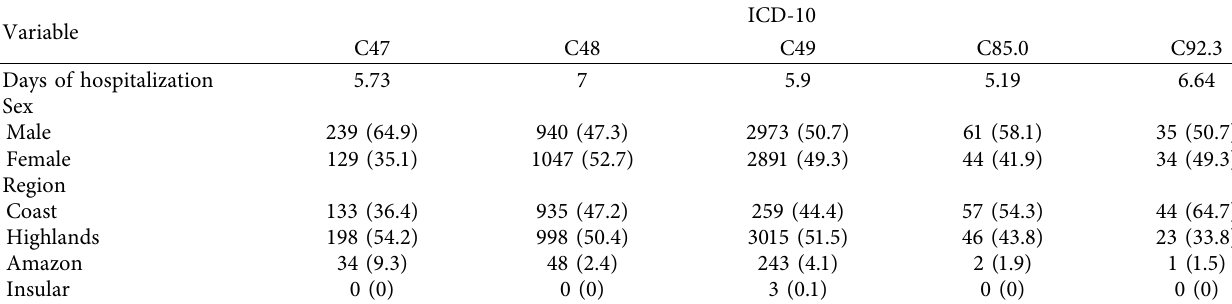
Table 2: General characteristics of patients with STS.